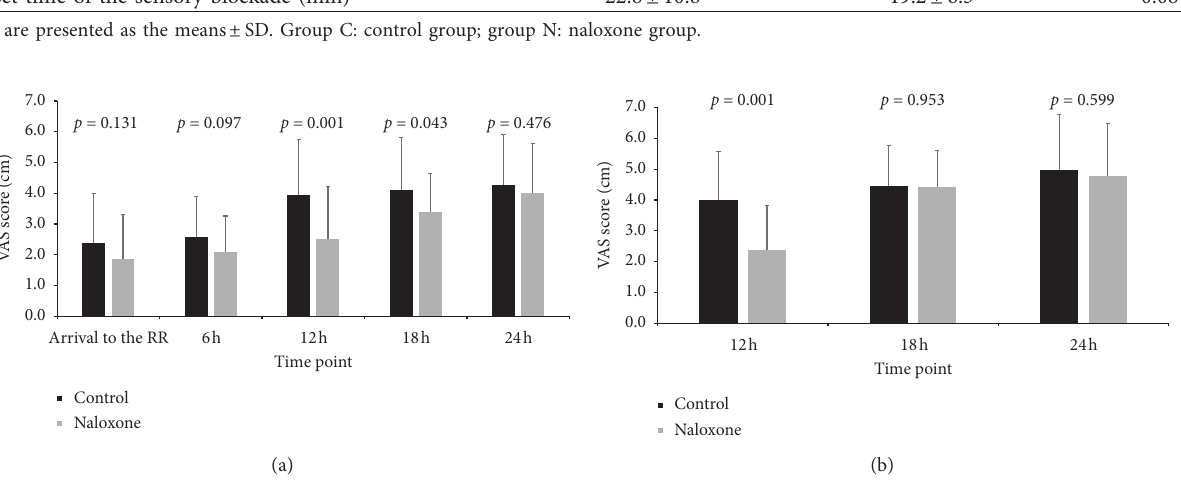
Figure 2: The VAS scores at rest (a) and during activity (b) of the knee at different time points before and after the operation. RR: recovery room; VAS: visual analog scale.